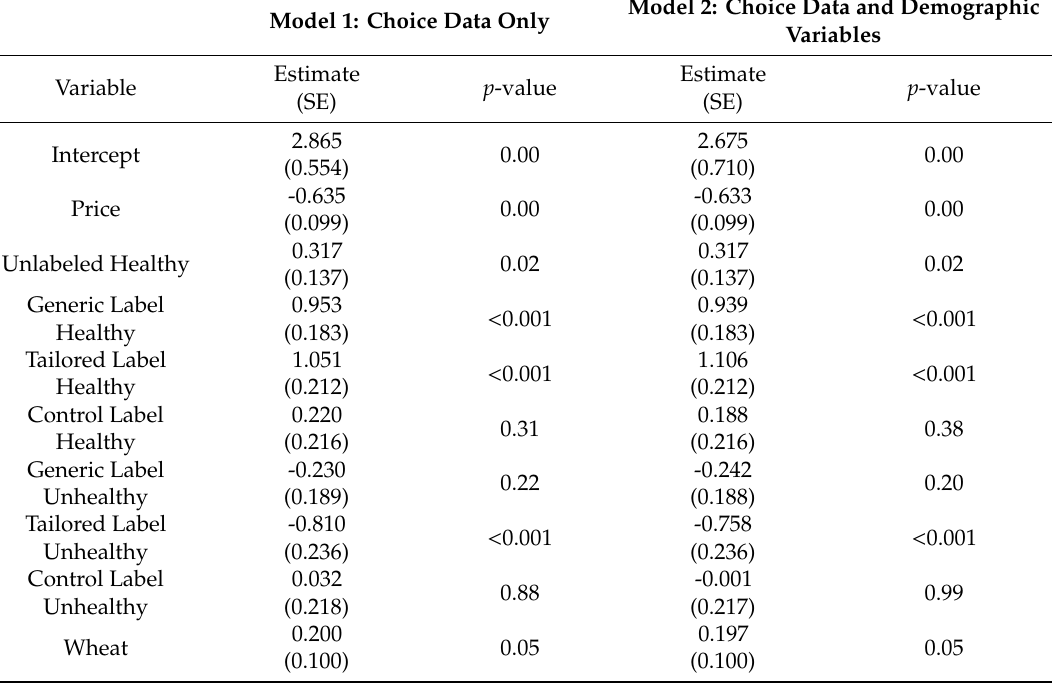
Table 2. Mixed e ff ects regression results of the influence of labels on product